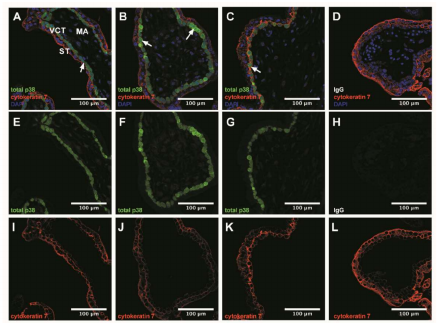
Figure 2. p38 immunodetection in 7–9 Gestational Weeks (GW) chorionic villi embedded in agarose sections. Total p38 was stained with green 488 AlexaFluor, nuclei were stained with DAPI and cytokeratin 7 with red 546 AlexaFluor. ( A – D ) Channels merge of total p38, cytokeratin 7 and DAPI staining; ( E – H ) Total p38 was shown in chorionic villi; ( I – L ) Structure of chorionic villi was marked with cytokeratin 7. IgG negative control is presented in ( D , H , L ). Confocal microscopy 400 x, scale bar 100 µ m, n = 3 different placentas. ST, syncytiotrophoblast; VCT, villous cytotrophoblast; MA, mesenchymal